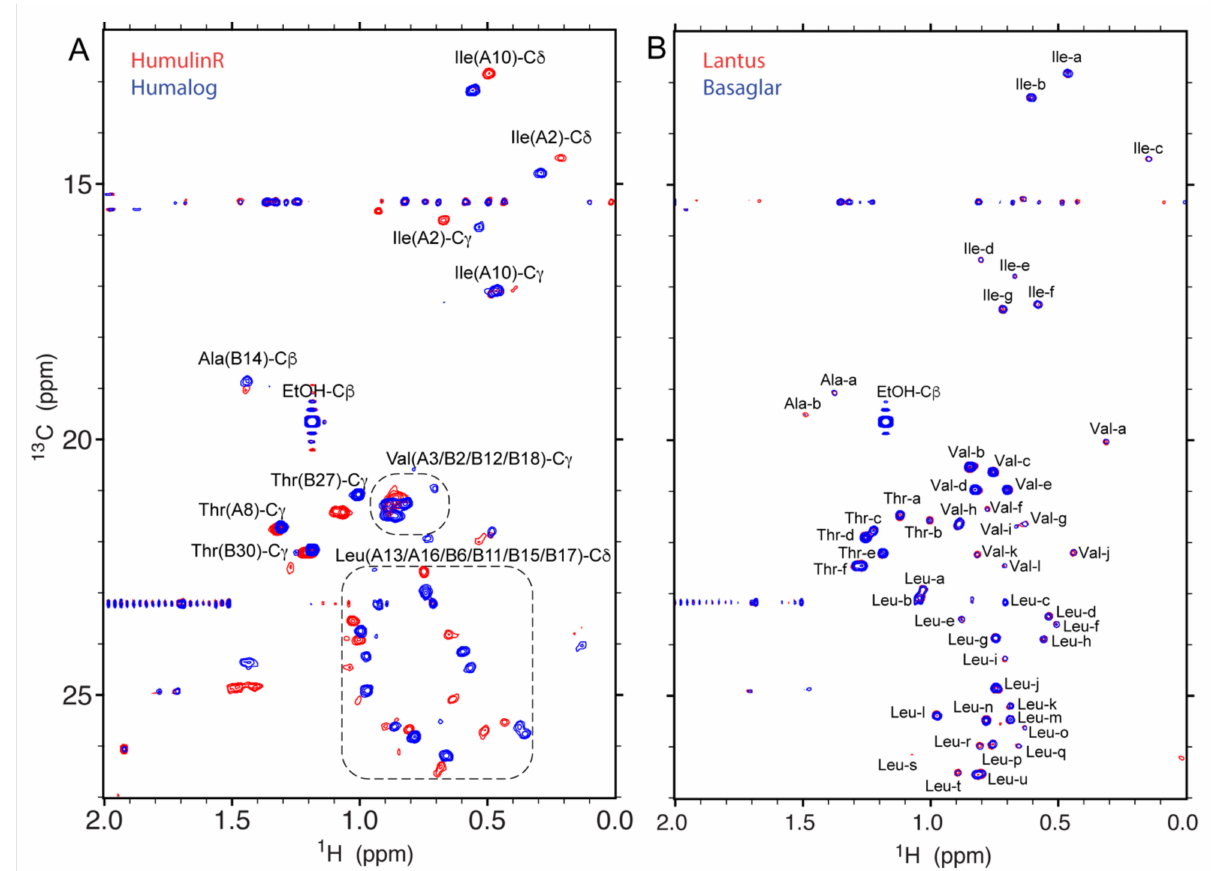
Figure 3. The superimposed 2D 1 H- 13 C HSQC NMR spectra between insulin drug products of HumulinR ® and Humalog ® ( A ) and between Lantus ® and Basaglar ® ( B ) collected using a 600 MHz spectrometer. The plotting threshold of intensity was at a signal to noise ratio of 5 and 10 for ( A ) and ( B ), respectively. The methyl spectra of insulin human and insulin lispro were approximately assigned according to the published assignments; ambiguities were observed in the Valine and Leucine clusters shown in dashed boxes ( A ). The spectra of insulin glargine cannot be definitively assigned due to a large change in the observed chemical shifts and each peak was labeled for possible amino acid type and with an alphabetic letter ( B